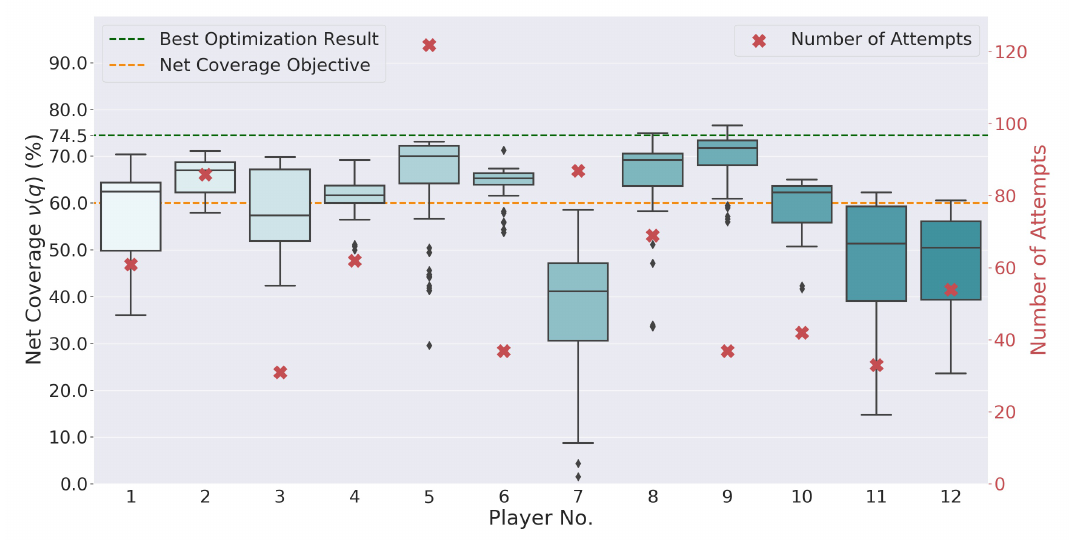
Figure 8. Net coverages achieved by the testers and number of attempts per tester.